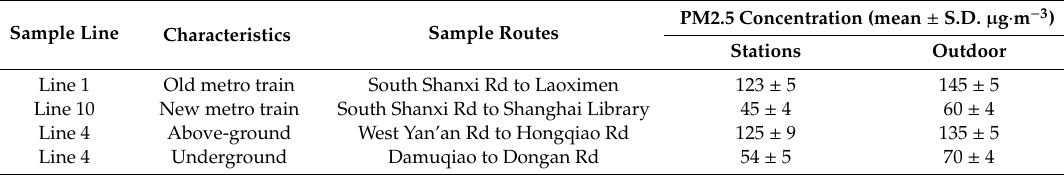
Table 1. Information about the selected lines and sample